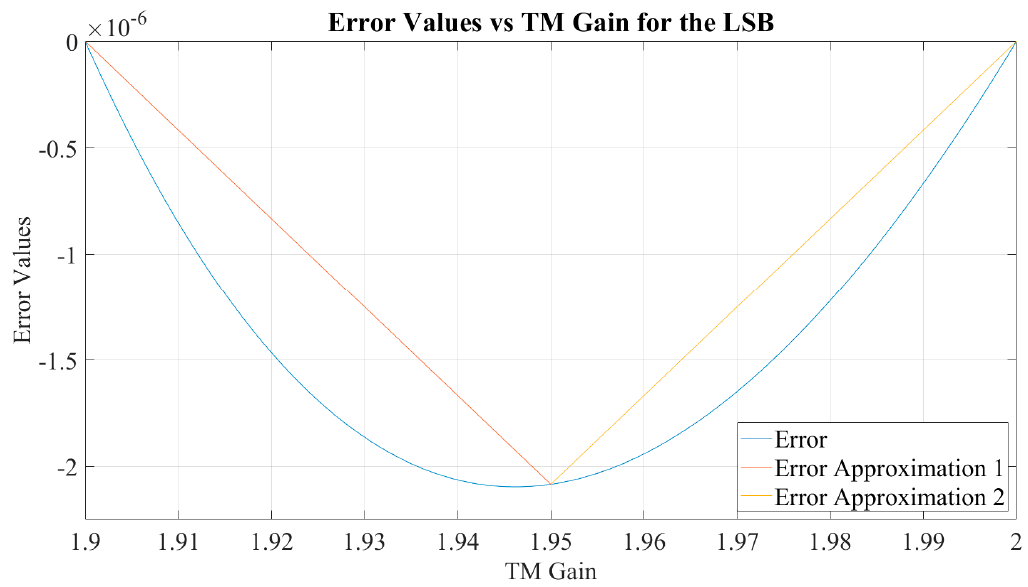
Figure 12. Establishing straight-line approximation of the LSB error values.